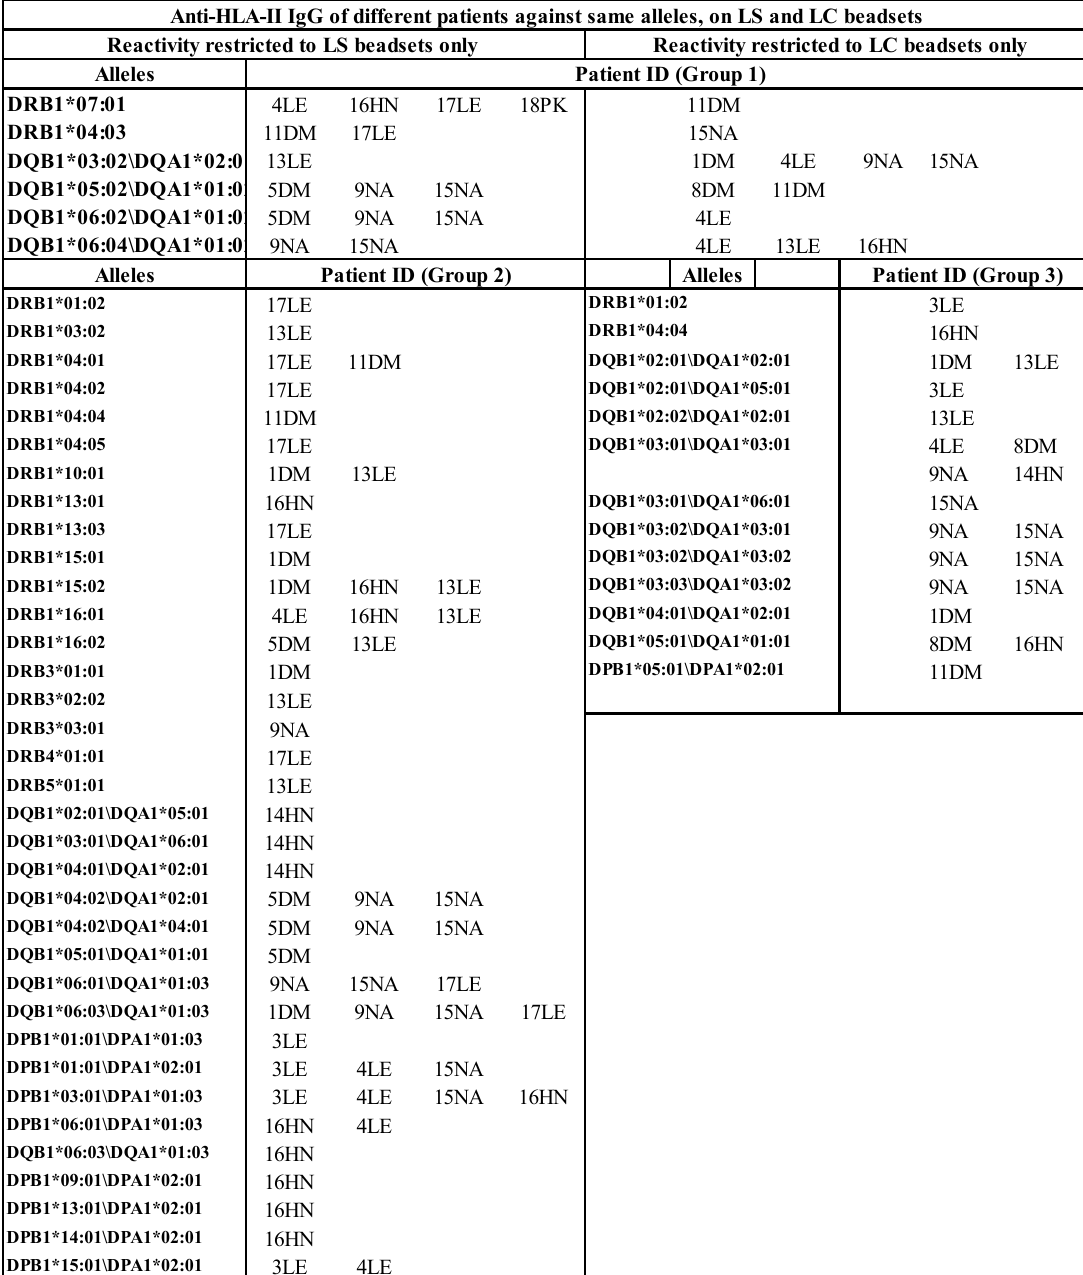
Figure 7. HLA antigens (HLA-I and HLA-II) recognized by the sera IgG (MFI >500) of different ESRD patients against same alleles differ between LABScreen and LIFECODES SABs. Several IgG reactivities are restricted only to LS (Group 2). Similarly, reactivities of several IgGs are restricted only to LC (Group 3).